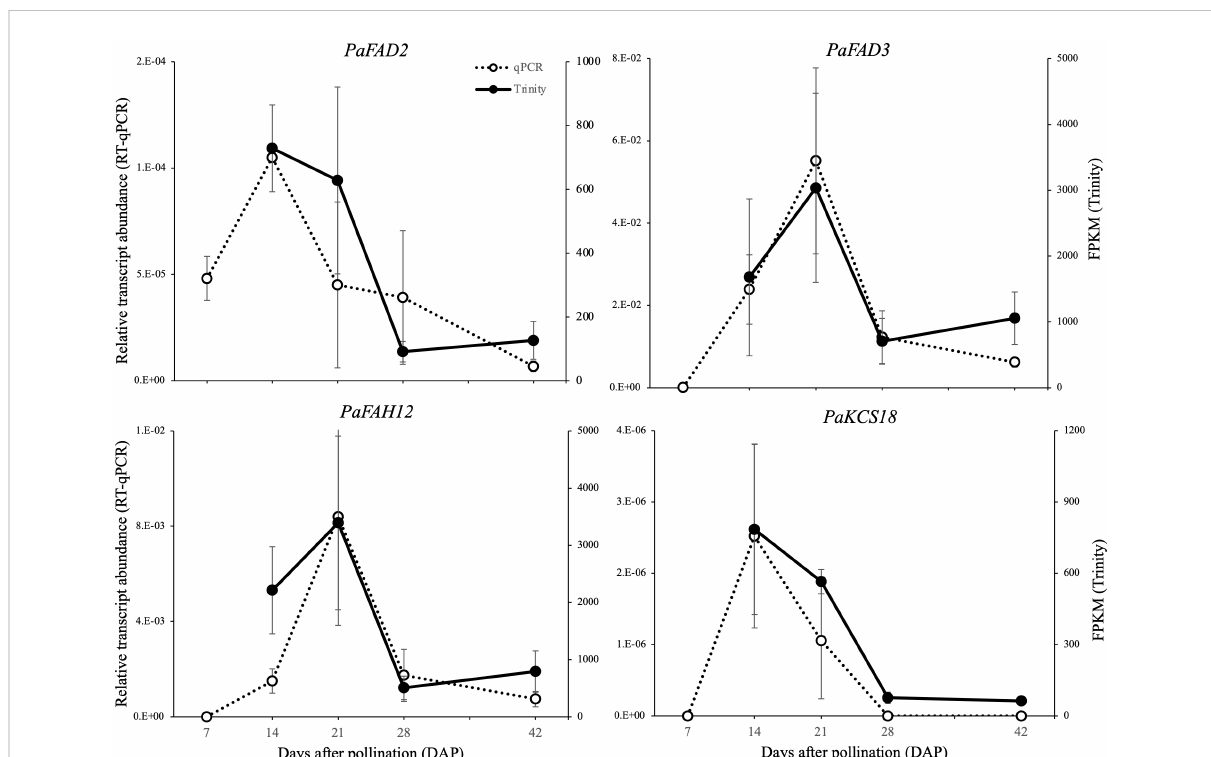
FIGURE 5 Comparison of the expression of HFA modi fi cation-related genes between the transcriptomic and quantitative PCR methodologies. The left and right axis represent the expression level quanti fi ed with qRT-PCR (relative transcript abundance) and Trinity (FPKM), respectively. Data are means±SD of n=3 biological